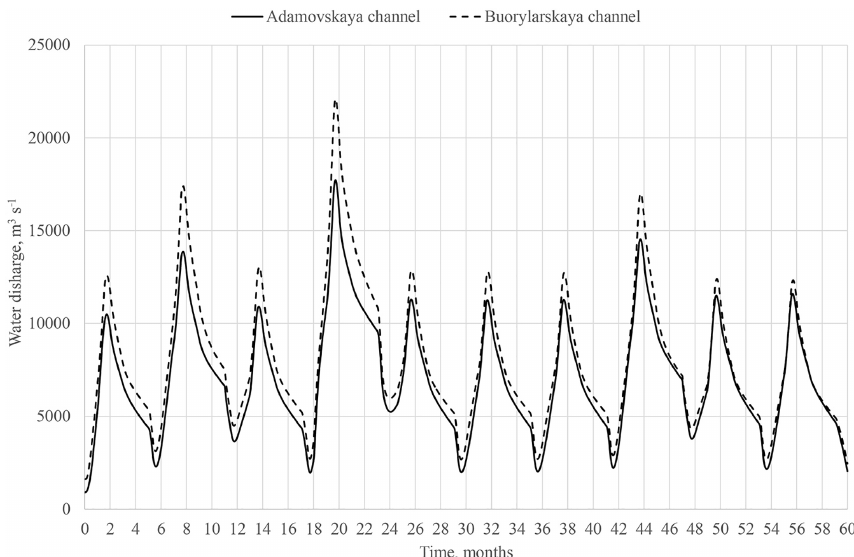
Figure 5. Distribution of water discharges between Adamovskaya and Buorylarskaya channels for 10-year forecast